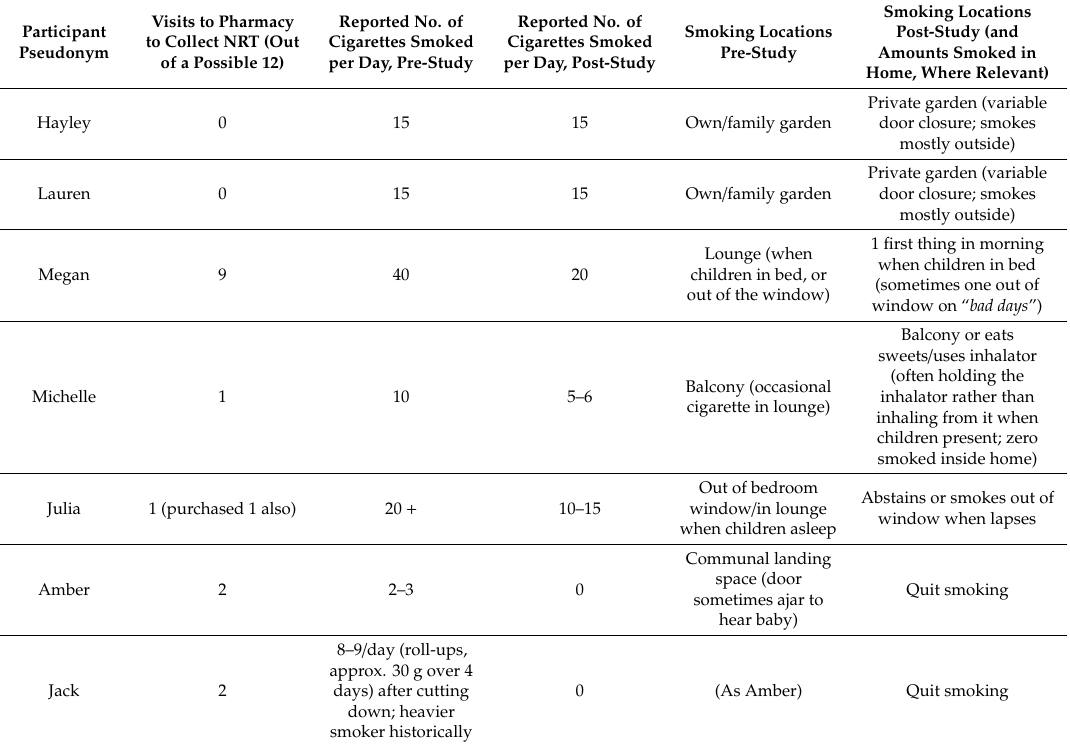
Table 1. Nicotine replacement therapy (NRT) uptake, and smoking pattern changes pre- and post-12-week NRT